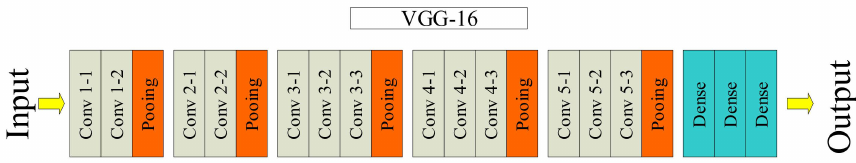
Figure 15. The structure of the